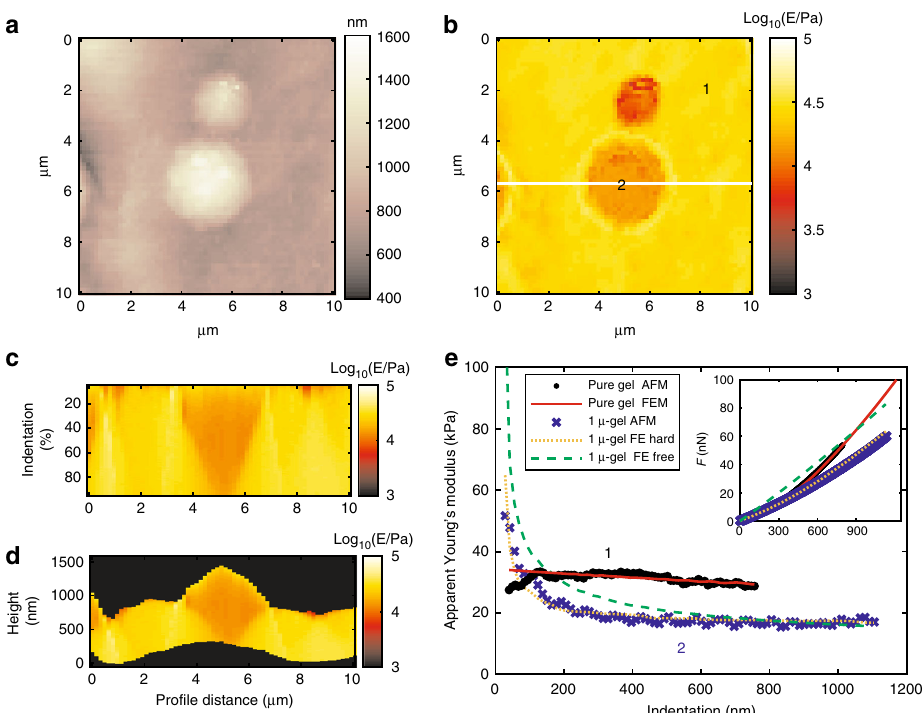
Fig. 3 Graphical results of mechanical analysis by AFMech Suite for 1 μ -gel. a Morphology map at zero force, vertical color bar represents height in nm. b Young ’ s modulus map in logarithmic scale at medium indentation (20 – 40% of maximum value). c Qualitative Young ’ s modulus tomography on relative indentation from white line in ( b ). d Qualitative Young ’ s modulus tomography on absolute indentation from line in ( b ). Vertical color bar for ( b – d ) represents logarithm base 10 of Young ’ s modulus in Pa. e Apparent Young ’ s modulus vs. indentation (inset: force vs. indentation) for points 1 and 2 of ( b ) comparing AFM results and FEM simulations for boundary conditions: no slip (FE hard) and free to slip (FE